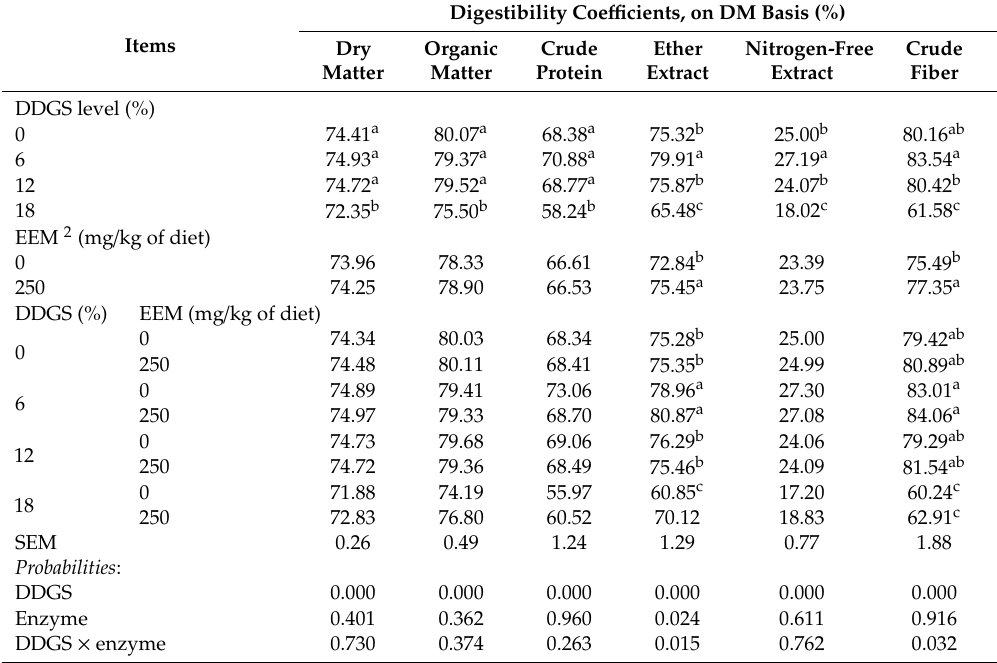
Table 7. Digestibility coe ffi cients of nutrients as a ff ected by DDGS 1 inclusion levels and enzyme supplementation through 32–42 weeks of